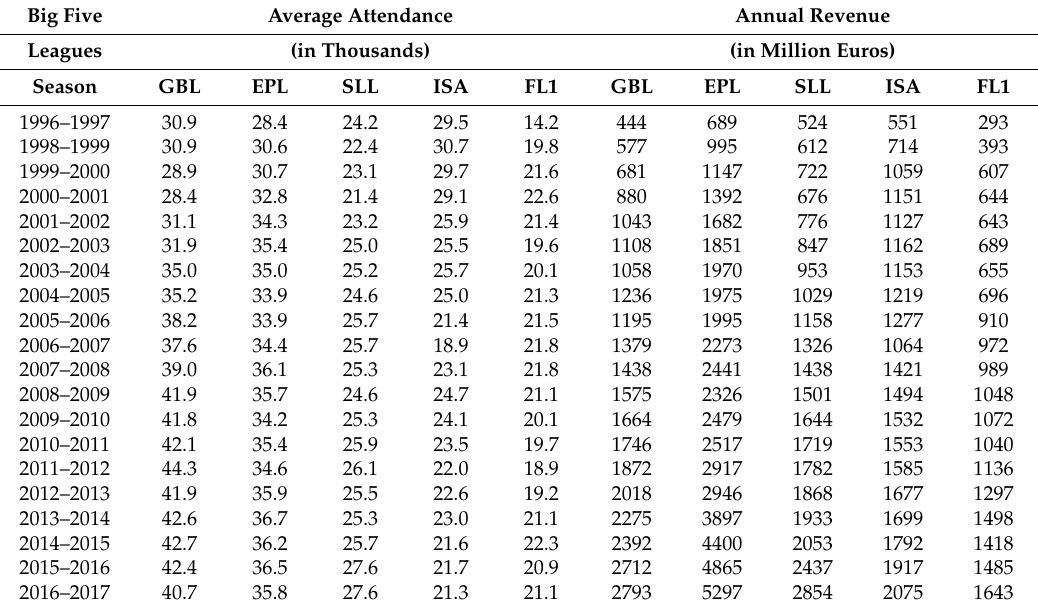
Table 3. The average attendance per match and annual revenue, Big Five 1997–2017. Big Five Average Attendance Annual